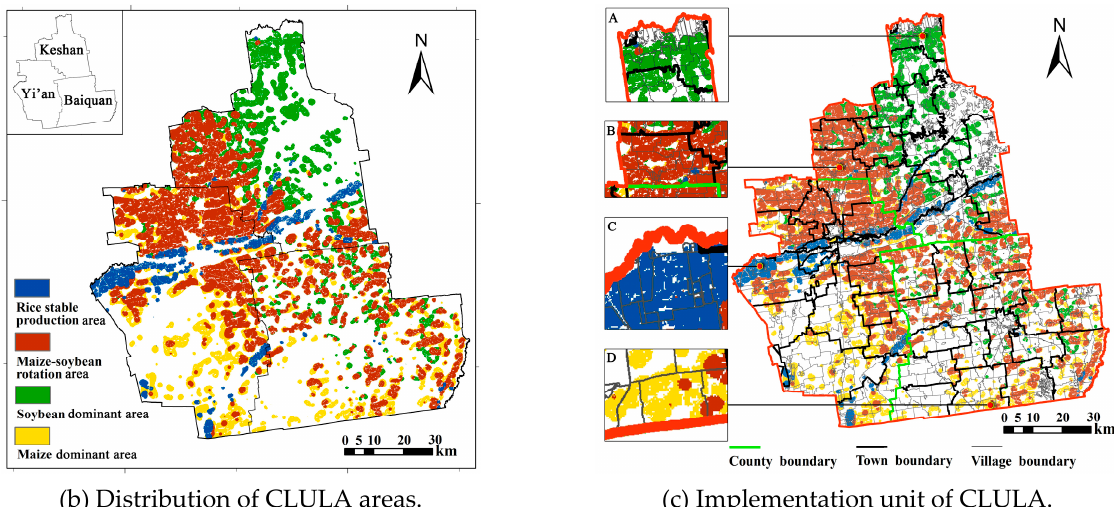
Figure 5. Statistics ( a ), distribution ( b ), and implementation unit ( c ) of